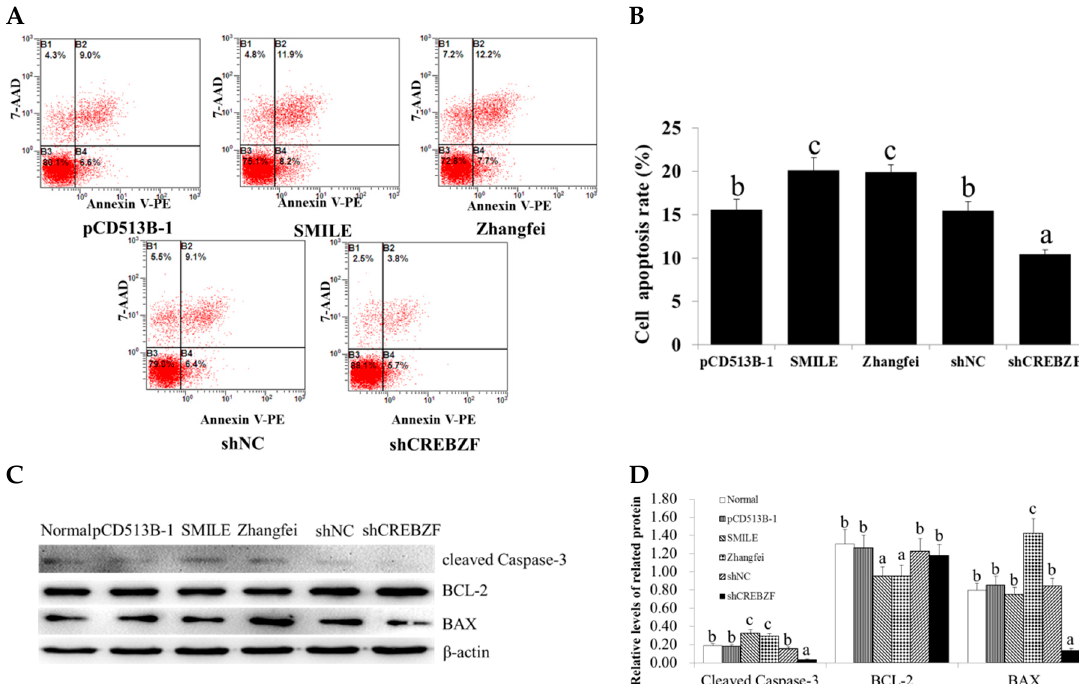
Figure 3. Effects of CREBZF overexpression and knockdown on apoptosis in ovarian granulosa cells. ( A , B ) Measurement of cell apoptosis via flow cytometry in granulosa cells transduced with CREBZF lentivirus for 48 h. ( C , D ) Expression of cell apoptosis-related genes (BCL-2, BAX, and cleaved Caspase-3) in ovarian granulosa cells transduced with CREBZF lentivirus for 48 h. The statistical analysis is shown in the bar graphs. Data are presented as the mean ± SEM. The bars with different letters indicate significant differences ( p < 0.05), while the bars with the same letter indicate no difference between their respective values.